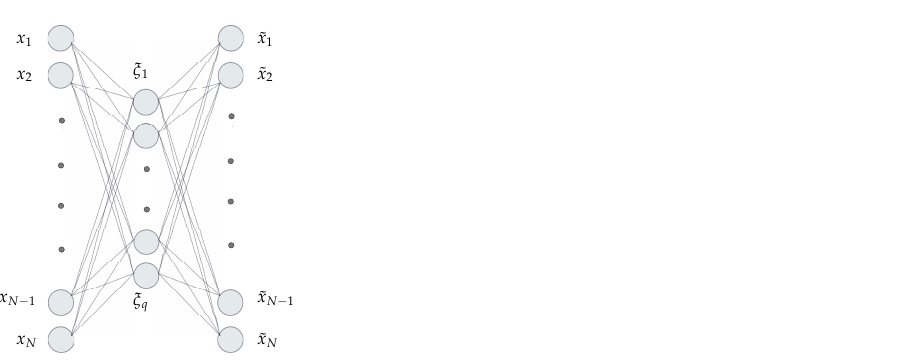
Figure 2. Autoencoder network for empirical basis identification using machine learning.